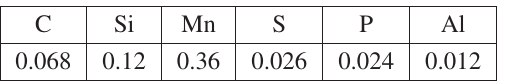
Table 1. Composition in mass % of the steel employed in the present study.